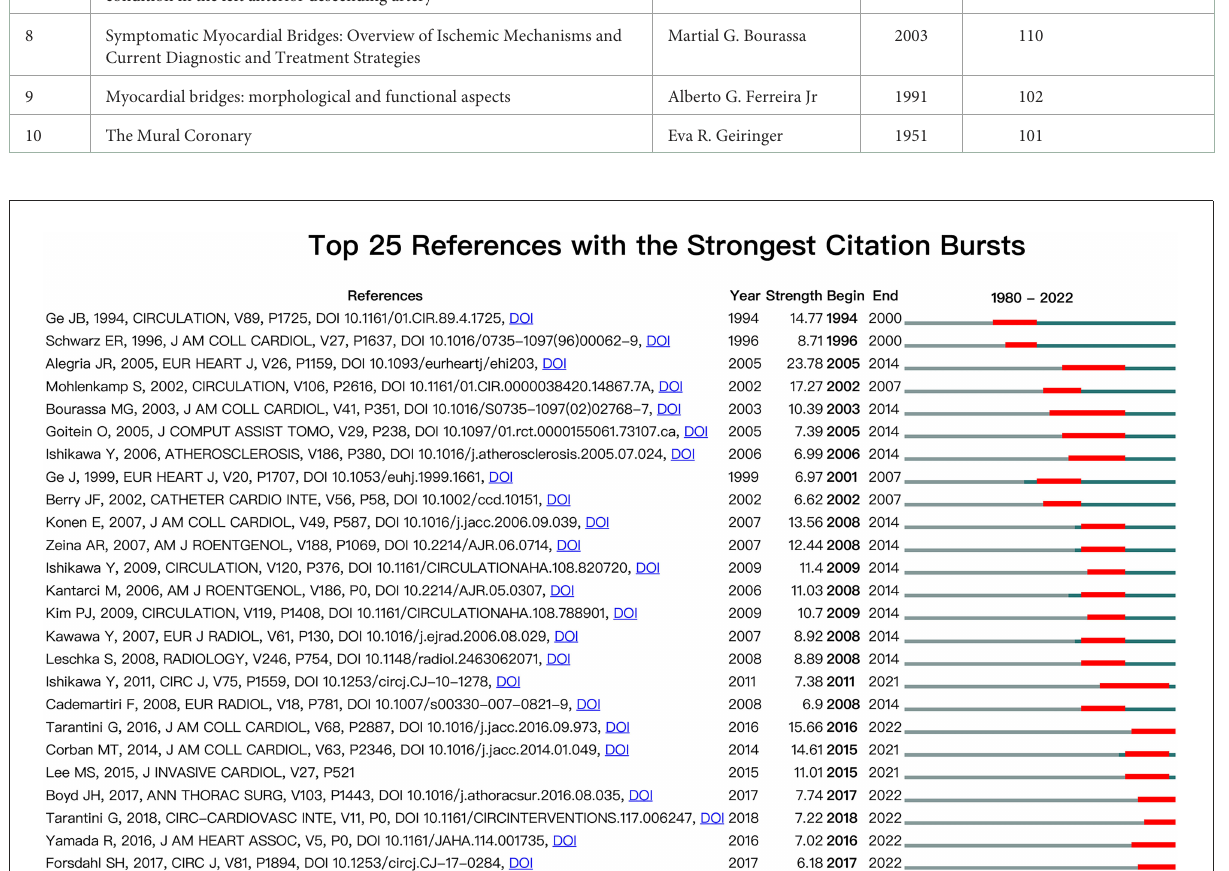
FIGURE6 CiteSpace visualization map of the top 25 references with the strongest citation bursts involved in the myocardial bridge. Two articles, authored by Tarantini, began to burst after 2015.